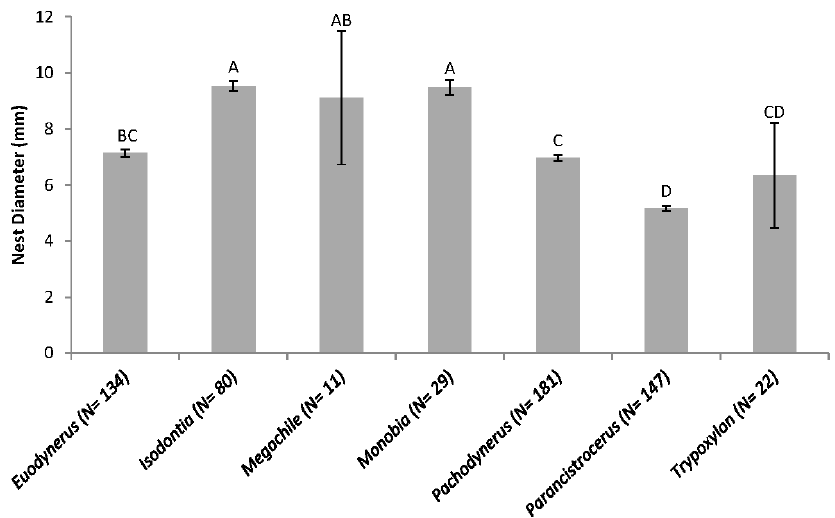
Figure 3. Common genera of wasps and bees and the mean nest entrance inside diameter (ID) (mm ± SE). Sample size (N) is the number of reeds in which nests were constructed and not the number of hatched individuals. The ID range of available reeds was 2.7 mm–13.4 mm. Columns with different letters are significantly different from one another ( χ 2 = 288.76, df = 6, p < 0.00001).